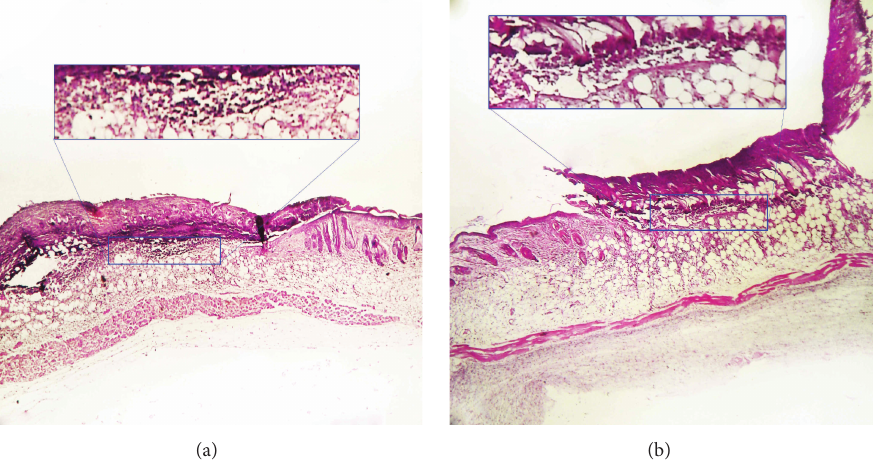
Figure 1: Photomicrographs of skin in Emu oil (a) and control (b) groups in the 4th day. Inflammatory cell density was higher in the Emu oil treated group in comparison with control group. Marked rectangle. Staining: Hematoxylin-Eosin, magnification: 40x.